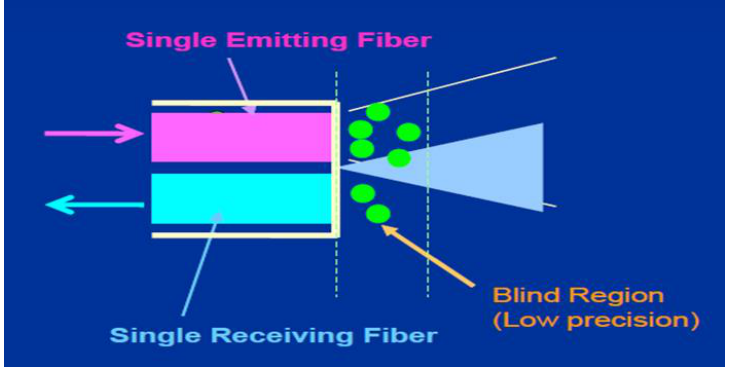
Figure 6. Presence of the Blind Region in Old Optical Probes Marked by Poor Measuring Volume and Low Reflected Light Intensity (Institute of Process Engineering of the Chinese Academy of Sciences).